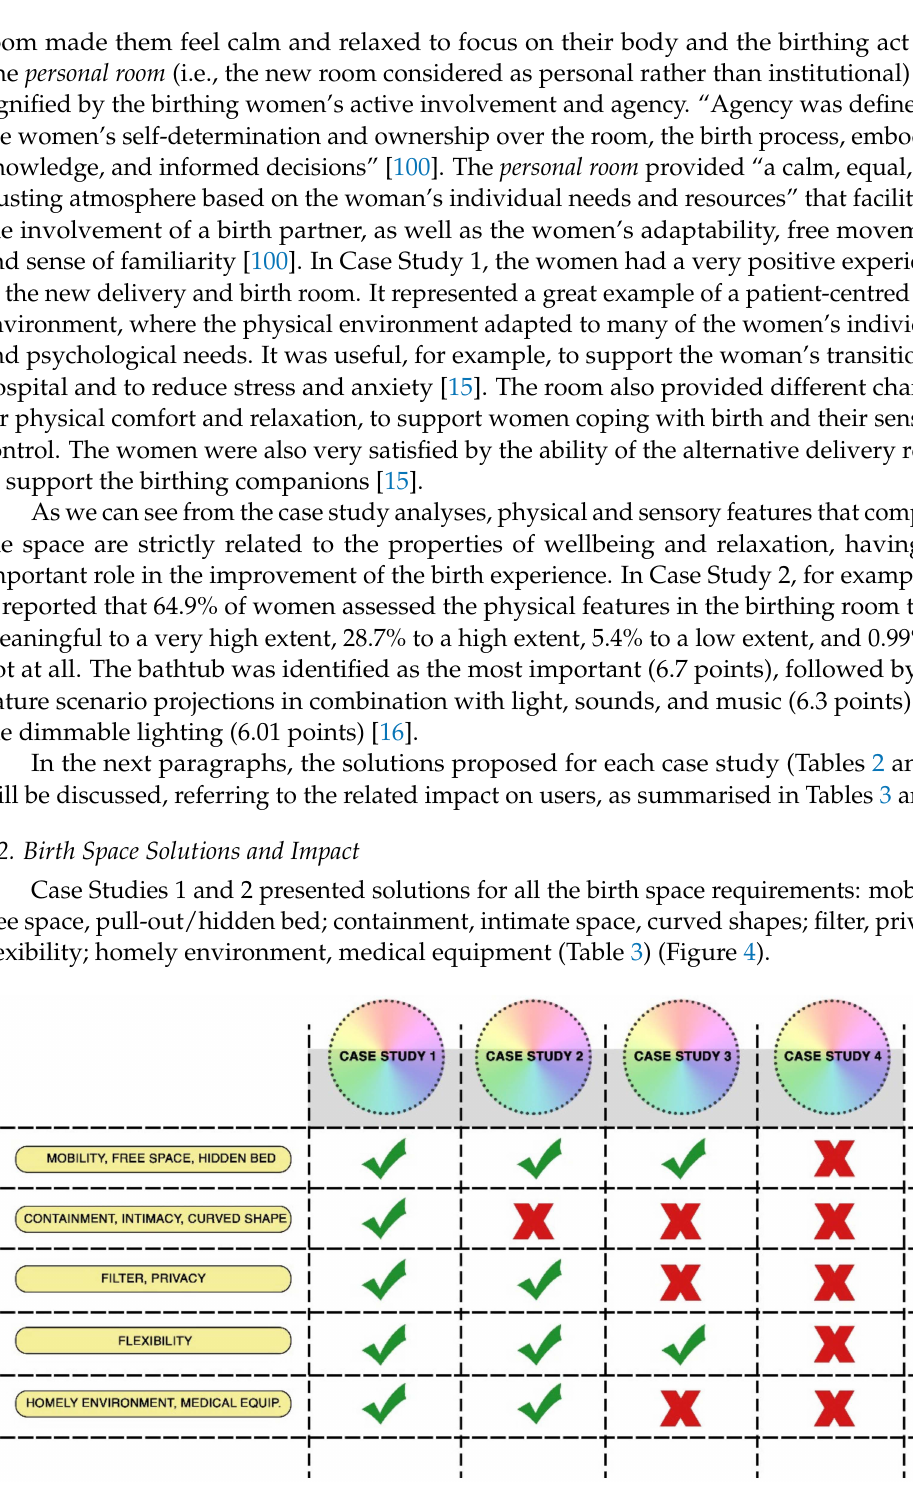
Figure 4. Diagram showing the presence of birth space solutions in case